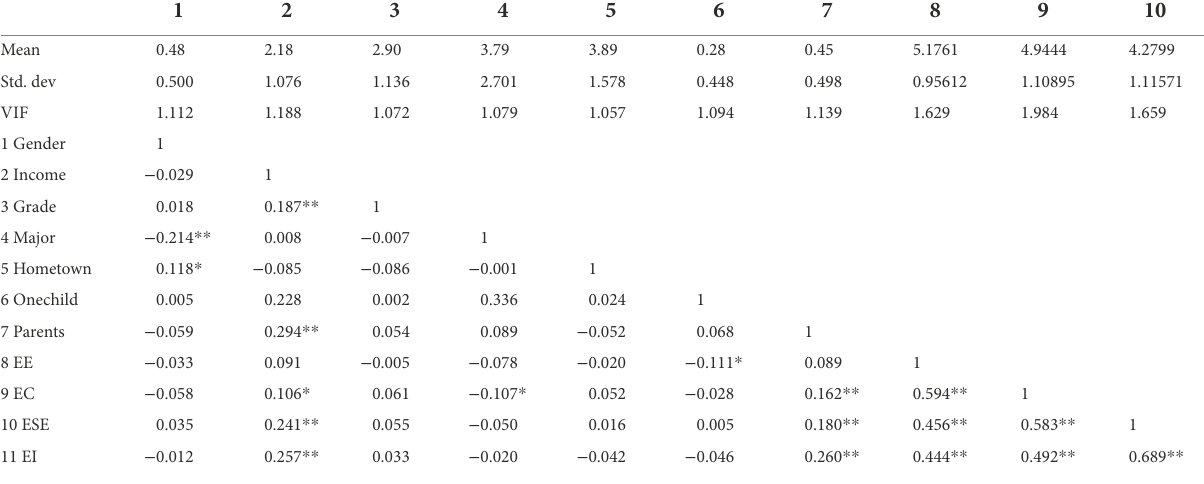
TABLE 4 Correlation coefficients and